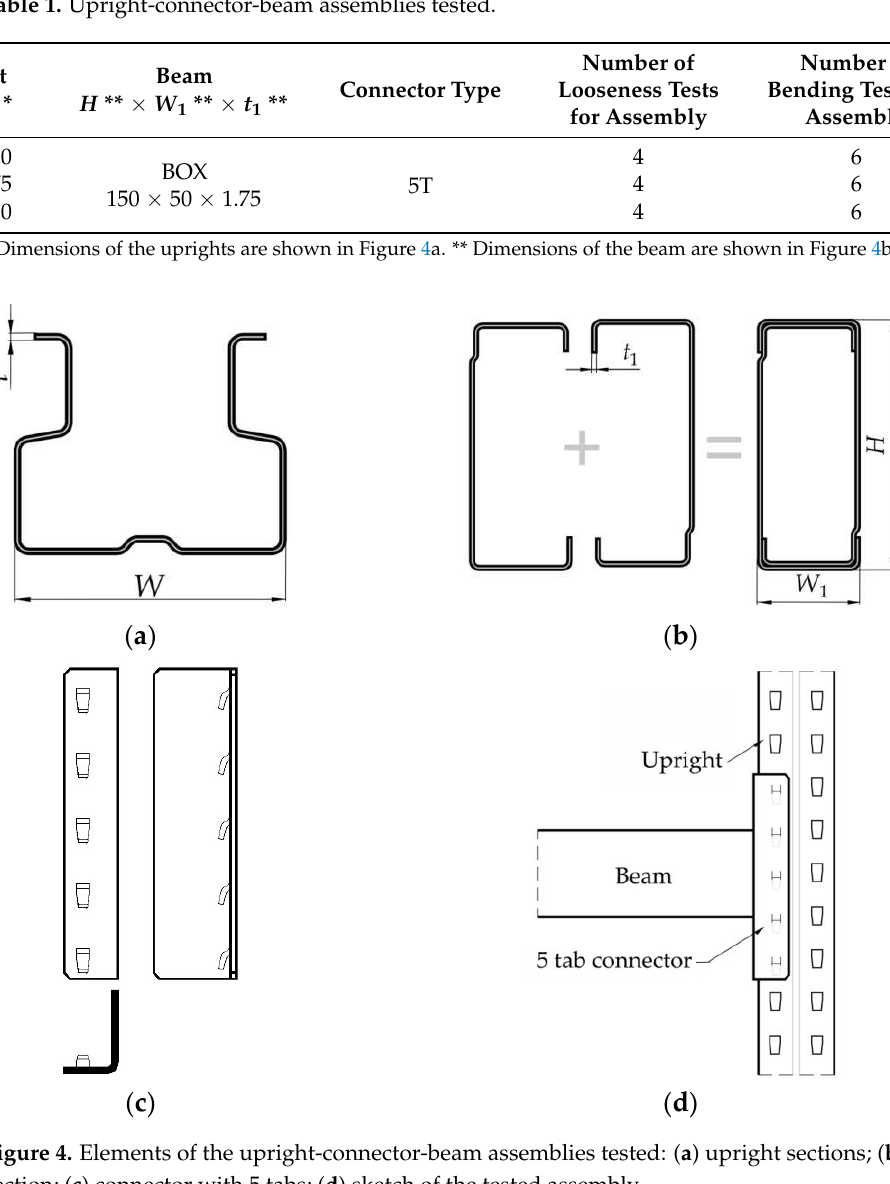
Table 1. Upright-connector-beam assemblies tested.